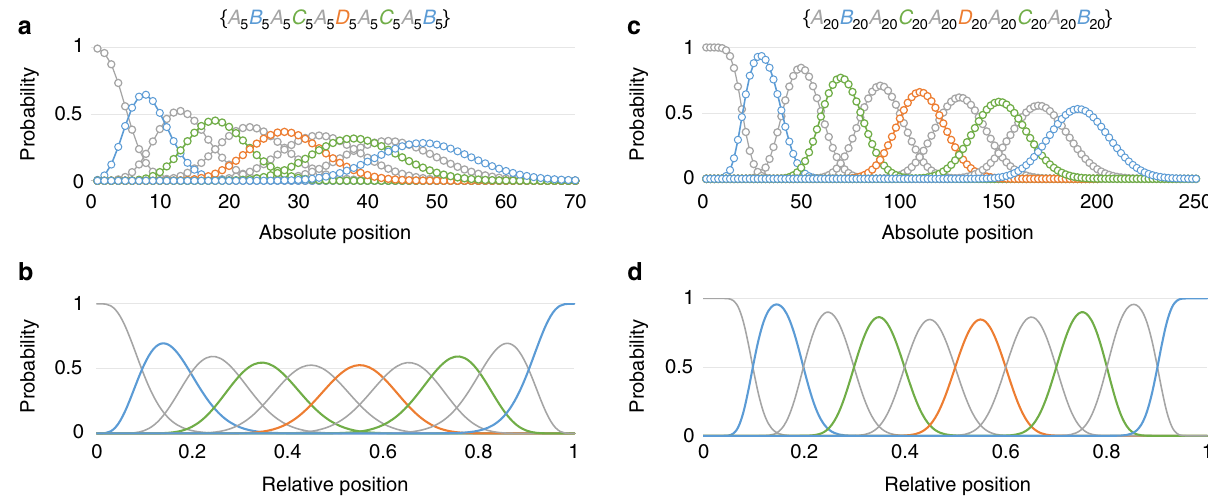
Figure 2 | Monomer distributions. Probability of finding monomers from each block of an { A 5 B 5 A 5 C 5 A 5 D 5 A 5 C 5 A 5 B 5 } ( a , b ) or {